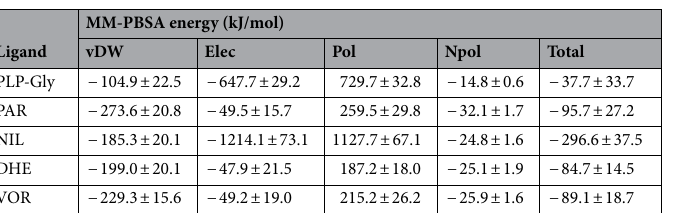
Table 1. MMPBSA analysis of selected drug candidates. NIL, nilotinib; VOR, vorapaxar; PAR, paritaprevir; DHE,